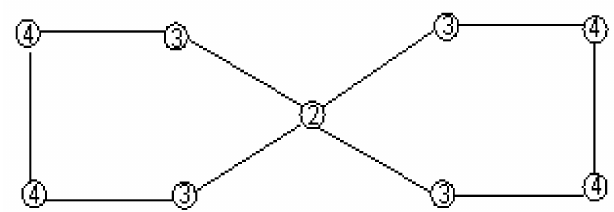
with eccentricity of 5